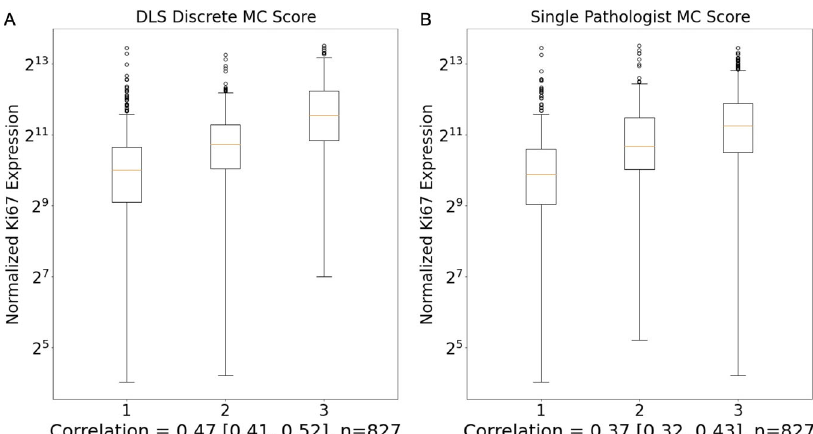
Fig. 5 Correlation of mitotic count and Ki-67 expression. Correlation of mitotic count and Ki-67 gene expression is shown for the mitotic count provided by the DLS ( A ) and by pathologist review ( B ). Values in brackets below plots represent 95% con fi dence interval for correlation. Box plot box edges and center line indicate quartiles (25th, 50th, and 75th percentile) of Ki-67 gene expression (TPM values via TCGA) for each MC score, with outliers (de fi ned as values beyond 1.5 times the interquartile range) plotted as black circles. The correlation values for DLS MC scoring with Ki-67 (0.47) and pathologist MC scoring with Ki-67 (0.37) were signi fi cantly different ( p = 0.002; permutation test) based on a permutation test with n = 1000 samples. DLS deep learning system, MC Mitotic